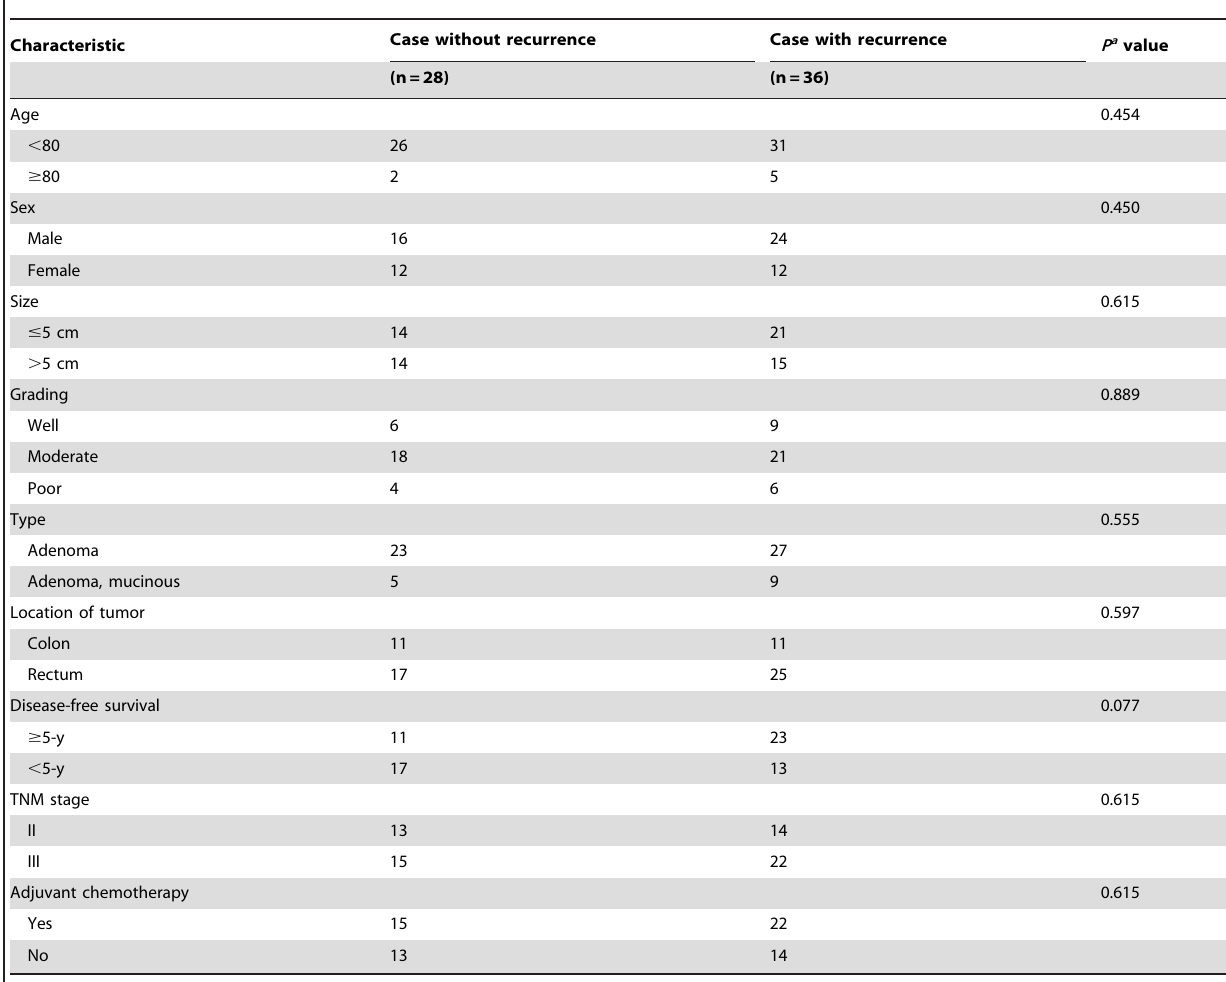
Table 1. Characteristics of 64 patients with colorectal